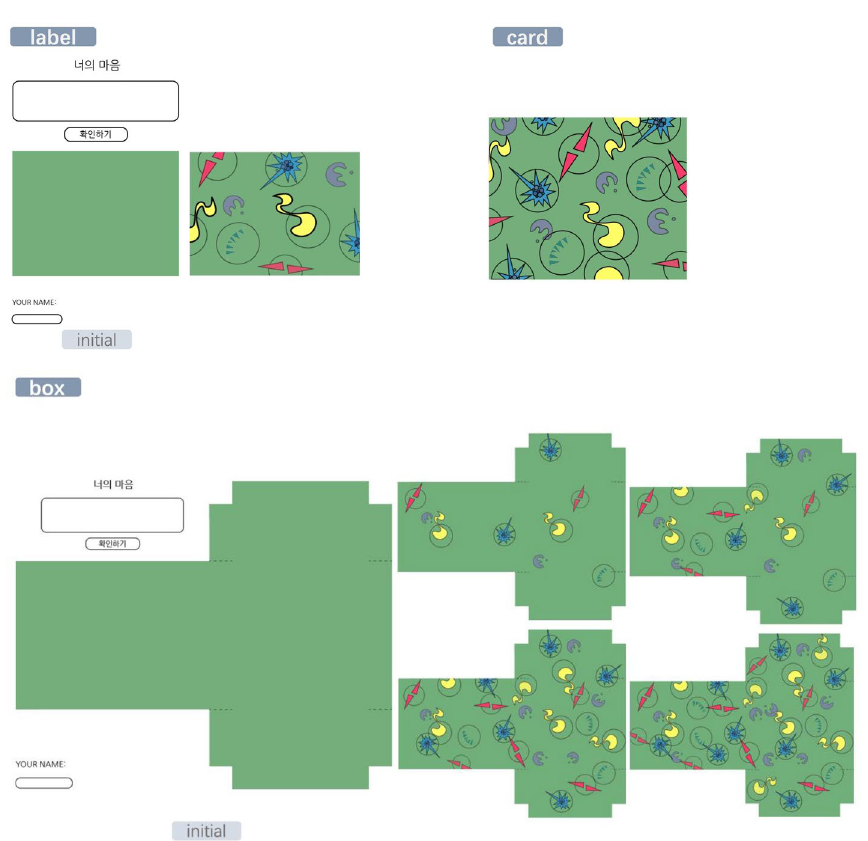
Fig. 7 Generation process of the label, greeting card, and packaging box for